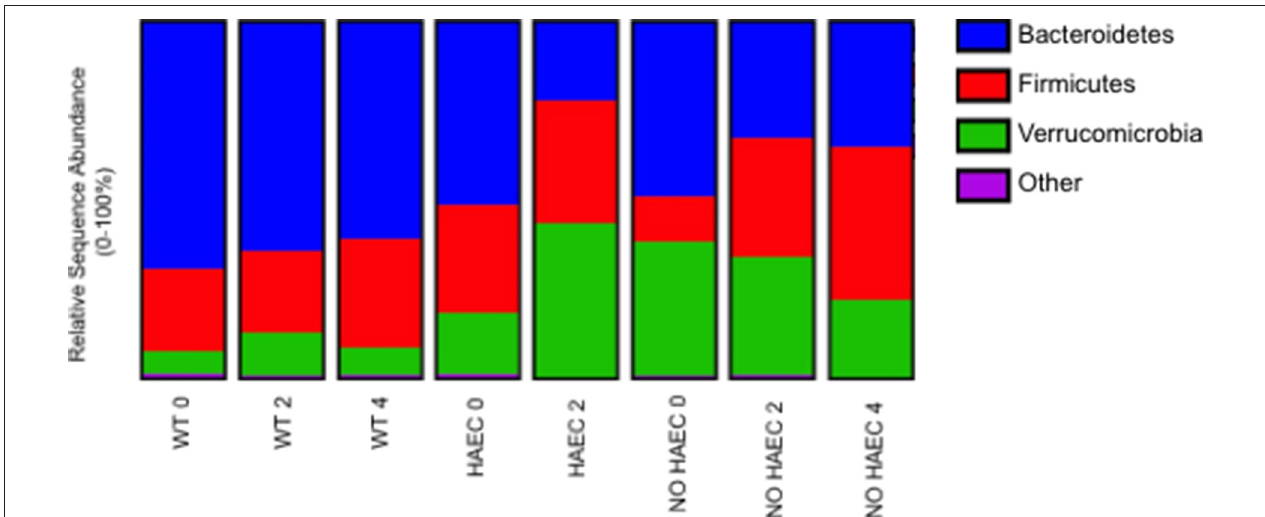
Figure 5 | Fecal bacterial phyla at several times in relation to pull-through surgery from WT and Ednrb −/− mice with and without HAEC. Data were generated by analyses of 16S rRNA gene sequences. n = 8 (WT 0, 2, 4), 6 (HAEC 0, 2), 4 (NO HAEC 0, 2), 2 (NO HAEC 4). See Supplemental Tables s2, s3 for more details including statistical